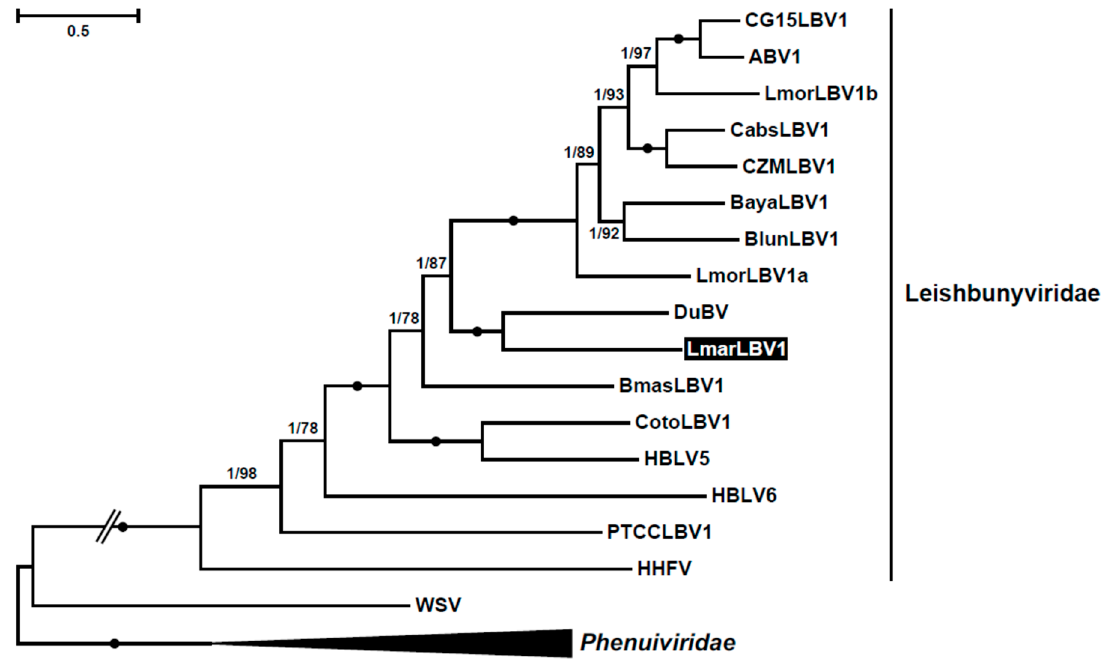
Figure 3. RDRP-based maximum likelihood reconstruction of leishbunyaviruses' phylogeny. Double-crossed branch is at 50% of its original lengths. Branch supports are Bayesian posterior probability and maximum likelihood bootstrap, respectively. Black circles indicate maximal (1/100) statistical supports. The scale bar indicates the number of substitutions per site. The tree was rooted with the sequences of Phenuiviridae . Lesihmania martiniquensis leishbunyavirus 1 ( Lmar LBV1) described here is highlighted in black. Abbreviations and GenBank accession numbers are in Table S2 [32].